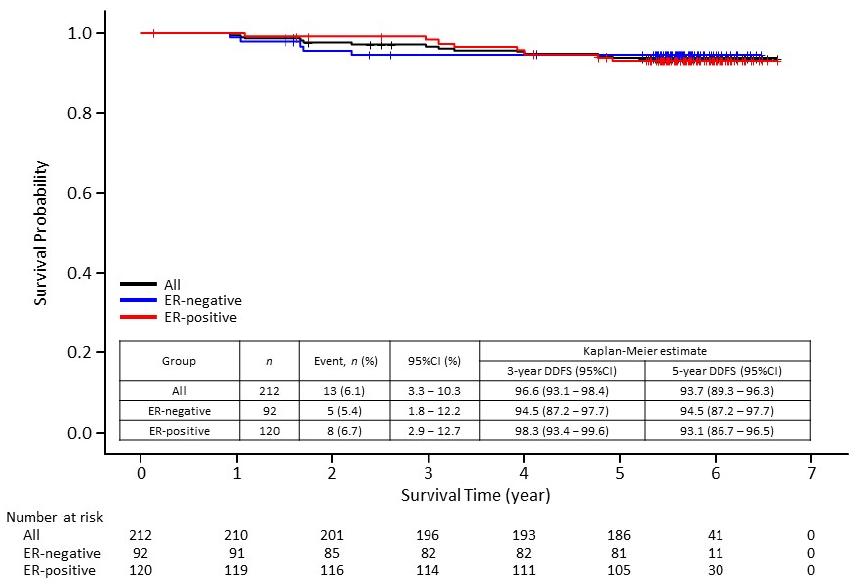
Figure 2. Kaplan–Meier curves of distant disease-free survival (DDFS) in 212 patients enrolled in the Neo-LaTH study comprising 92 estrogen receptor (ER)-negative and 120 ER-positive patients. CI, confidence interval.